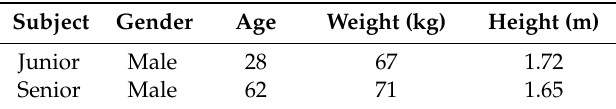
Table 3. Data of the